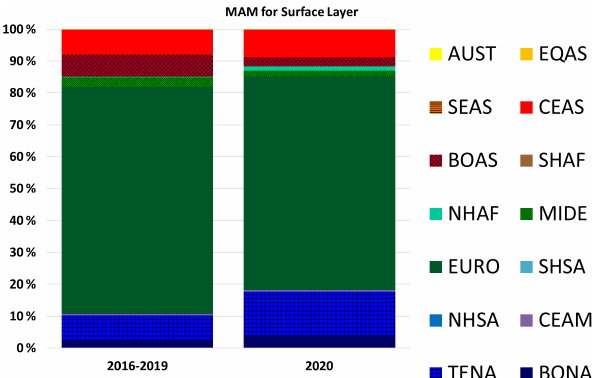
Figure 13. Contribution from different source regions to the CO in the surface layer at Frankfurt in MAM 2020 compared with MAM 2016–2019. The colours correspond to the regions in Fig.